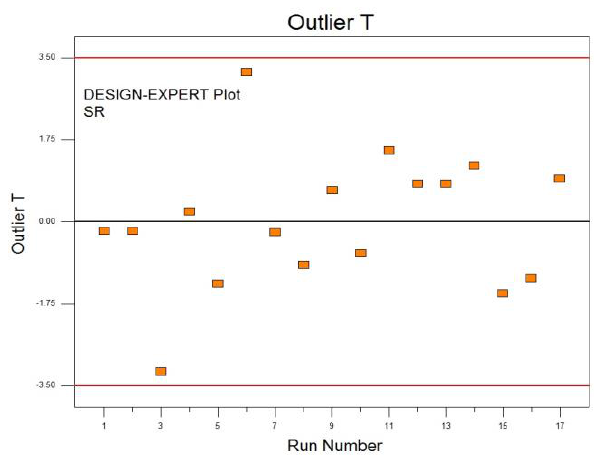
Figure 5: The normal plot of residuals